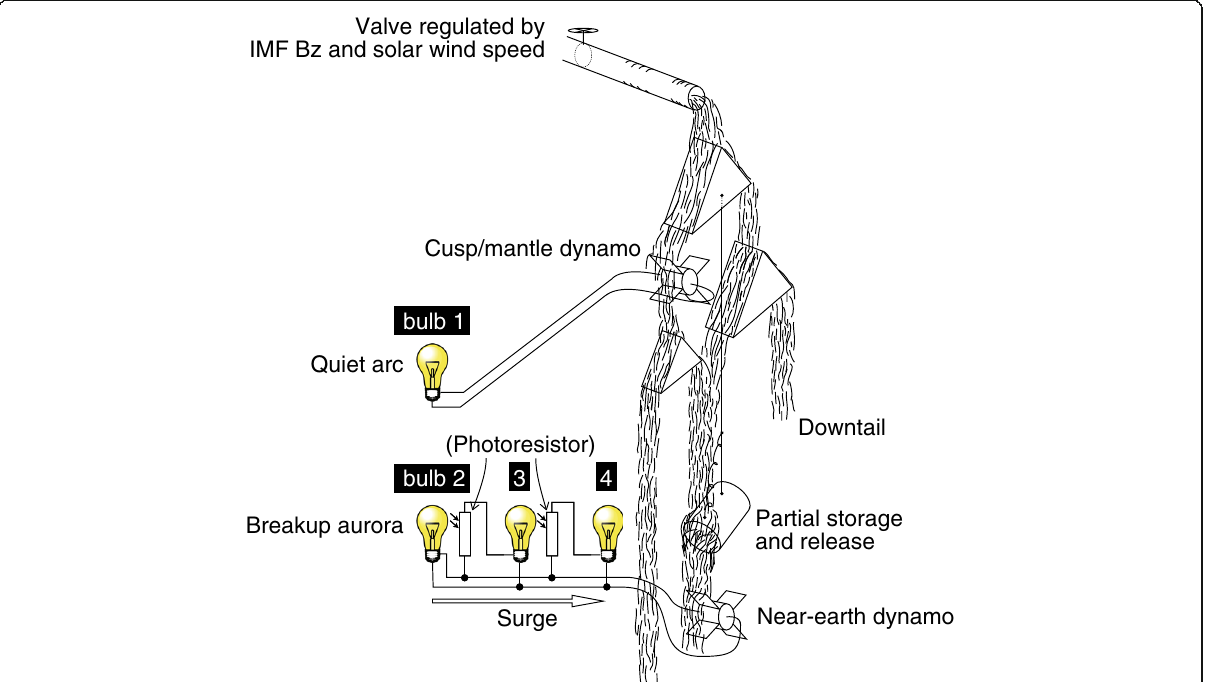
Fig. 17 Conceptual illustration of the possible chain reaction of auroral substorm in terms of energy transfer from the solar wind to the ionosphere. The quiet arc (bulb 1) is associated with the cusp/mantle dynamo. The breakup aurorae (bulbs 2, 3, and 4) are connected to the near-Earth dynamo. Illustration is based on Akasofu